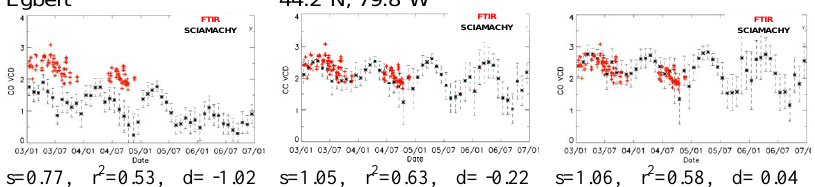
these areas (such as industrial regions and biomass burning regions) are of great interest for the test of current emission